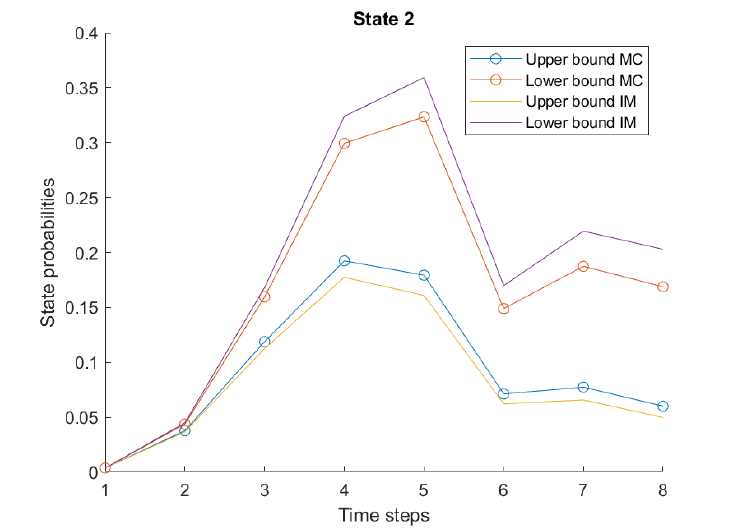
Figure 6. Monte Carlo (MC) and Interval Mathematics (IM) bounds for the probability of state 2, in case of dependent uncertainty